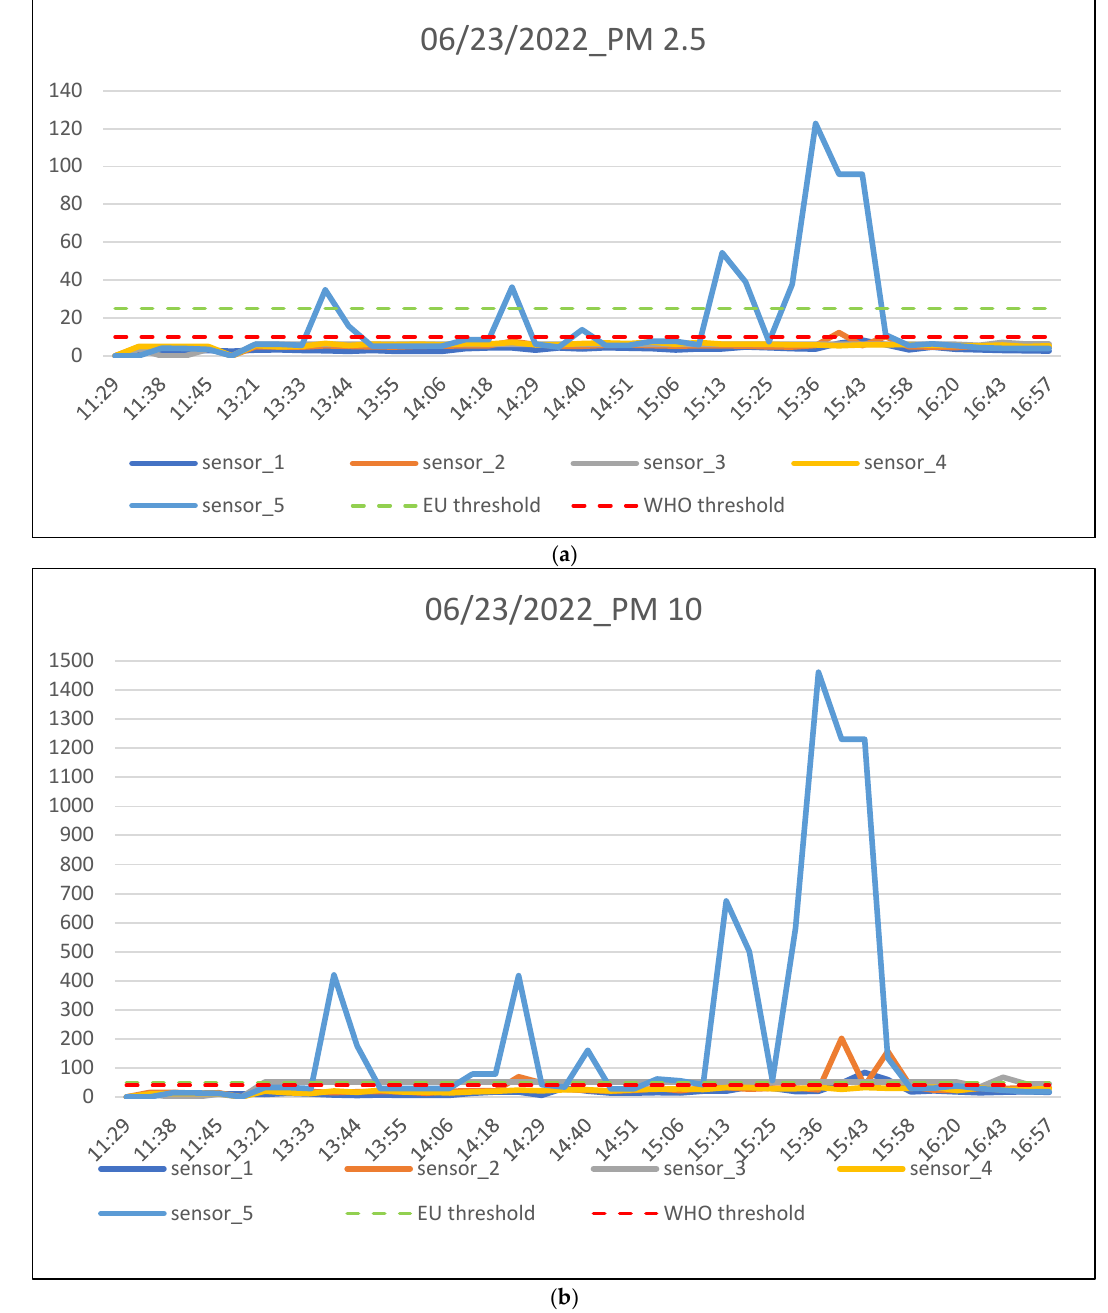
Figure 10. ( a , b ) Comparison between data recorded during active demolition work and after demolition work s stopped.